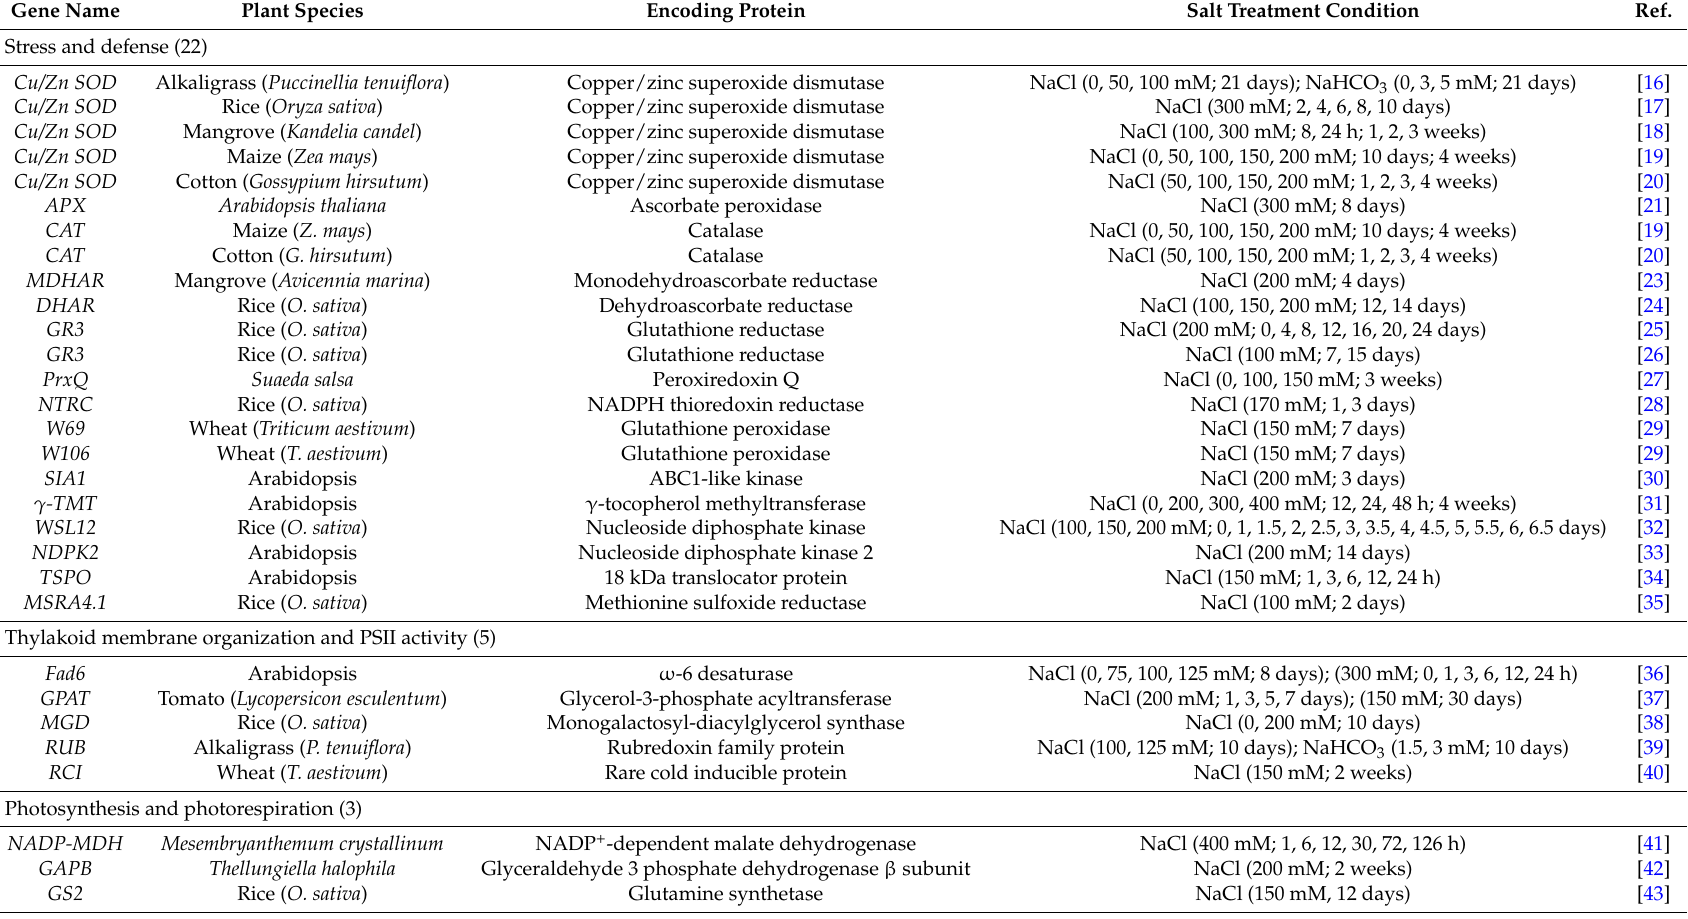
Table 1. List of genes encoding chloroplast proteins in response to